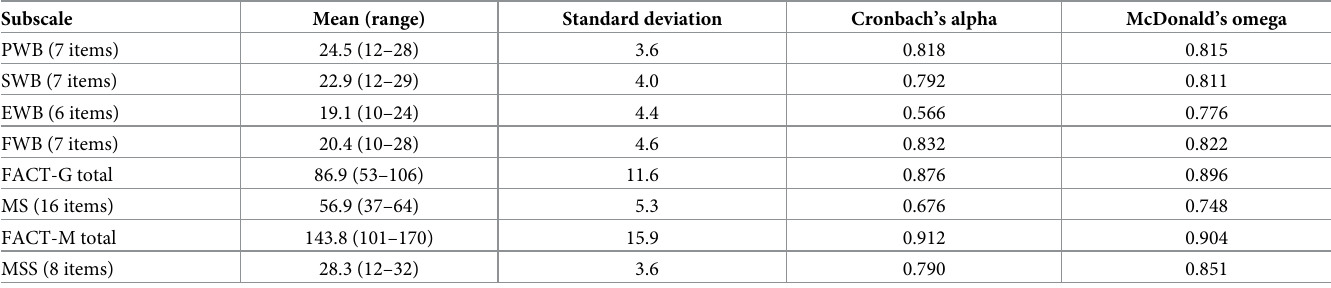
Table 2. Descriptive statistics and reliability of the FACT-M questionnaire.